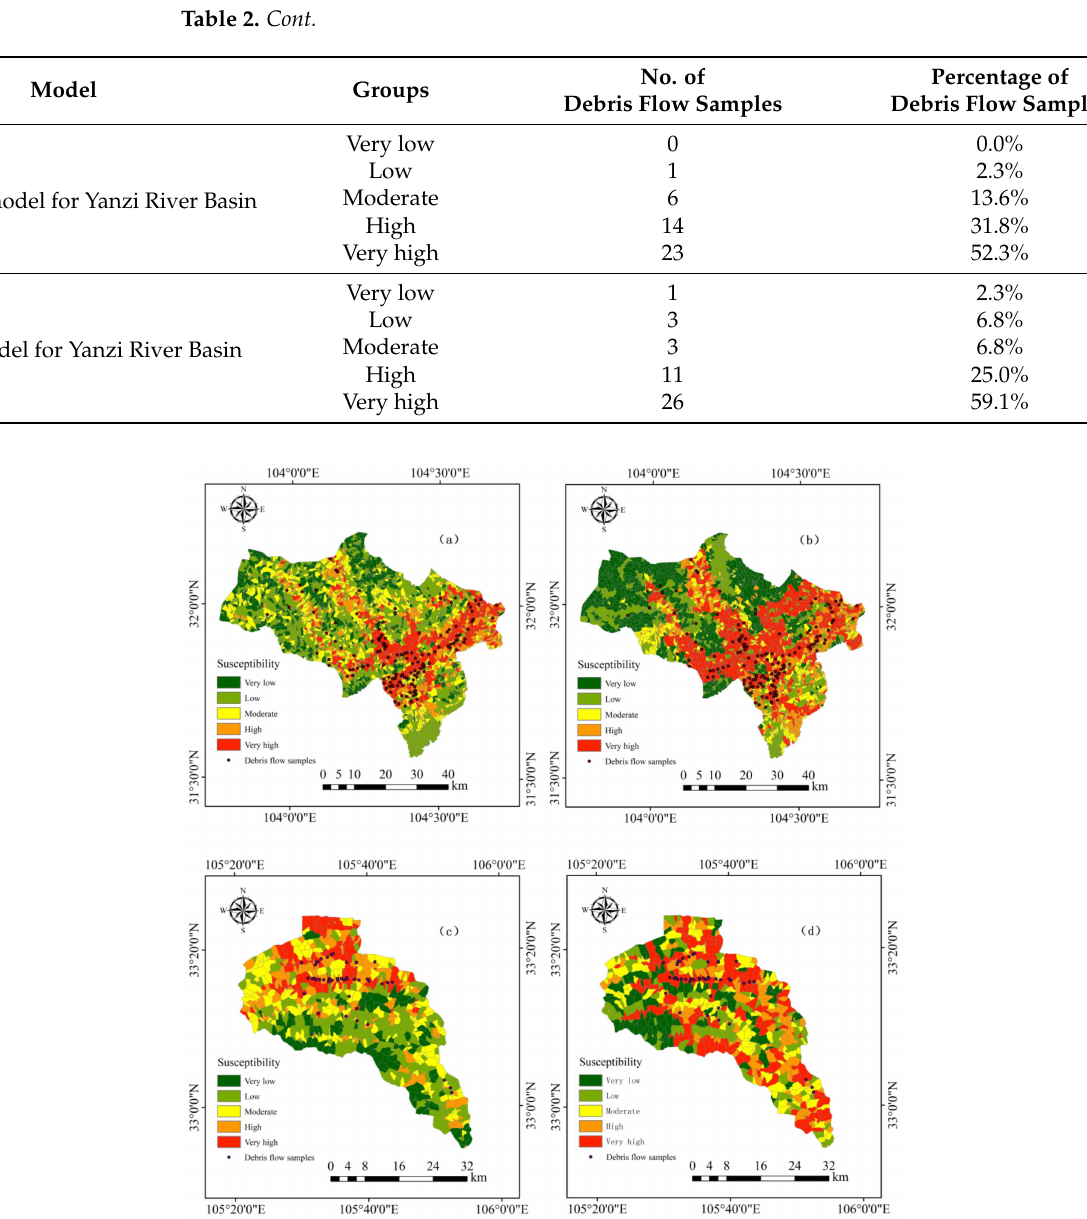
Figure 8. The debris flow susceptibility maps based on the: ( a ) Traditional model for Beichaun County; ( b ) Unified model for Beichuan County; ( c ) Traditional model for Yanzi River Basin; ( d ) Unified model for Yanzi River